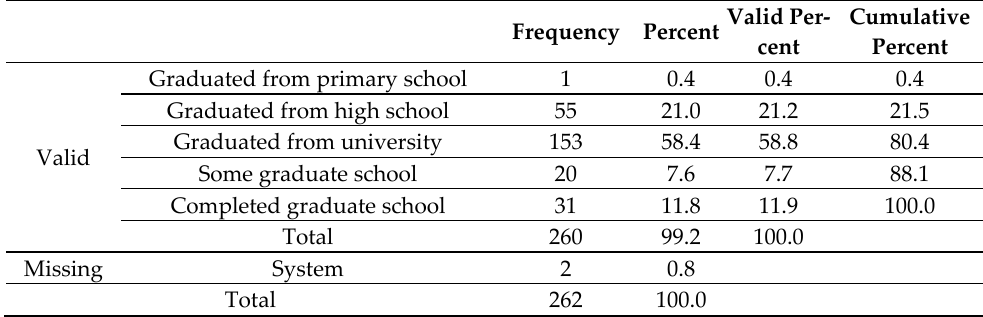
Table 4. Demographic characteristics of participants: education